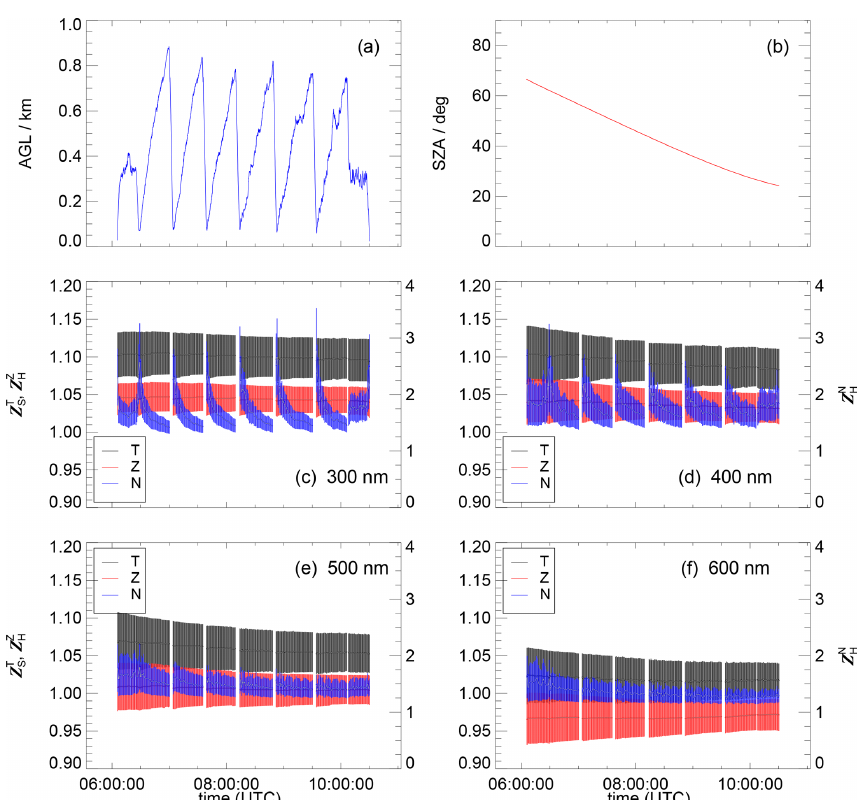
Figure 15. Zeppelin flight example with height profiles on 9 July 2012 about 40km east of Bologna, Italy (PEGASOS campaign). (a) Heights above ground (a.g.l.) and (b) solar zenith angles (SZAs). (c) – (f) Parametrized correction functions Z T wavelengths, with error bars indicating uncertainties. For clarity, 1min averages are shown with grey overlays. The right-hand y axes refer to the Z N H